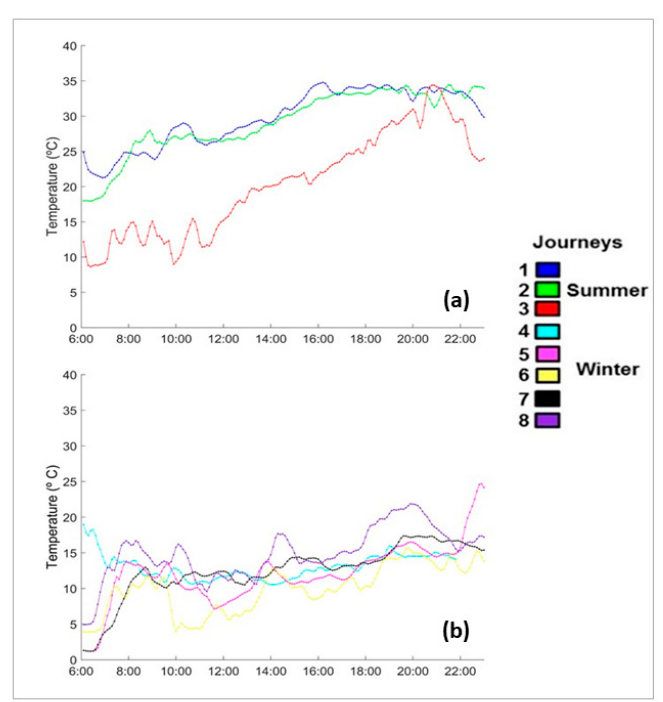
Figure 1. Evolution of the average temperatures (in °C) inside the livestock vehicle during transport from Spain to Portugal in ( a ) summer and ( b ) winter throughout the day beginning from loading at 6:00 until unloading at 23:00.